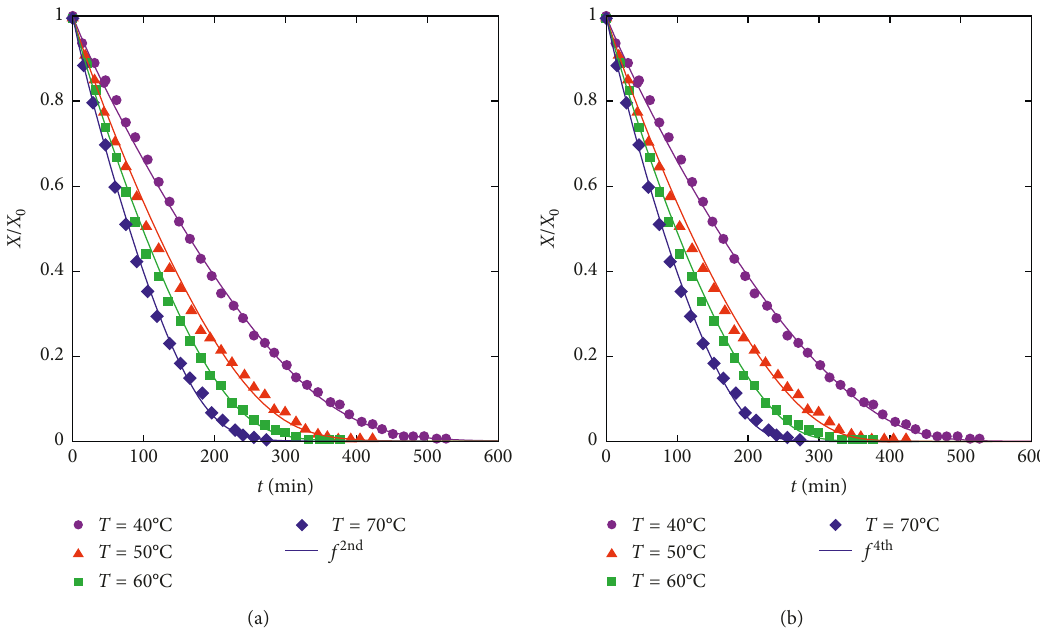
Figure 6: Experimental data X / X square best fit with (a) f 2nd L 0 (cid:31) 6mm. Bi m (cid:31)